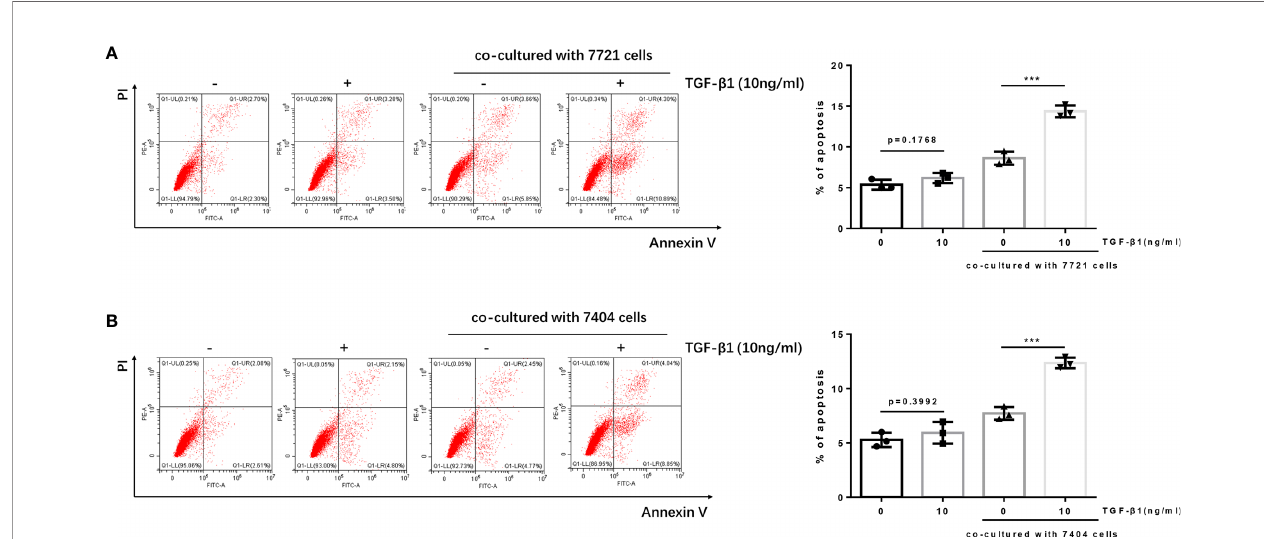
FIGURE 3 | Apoptosis of TGF- b 1-treated H9 cells is increased after co-cultured with HCC cells. (A) TGF- b 1-treated/untreated activated T cells were co-cultured with SMMC-7721 cells or cultured separately for 24 h; subsequently, the apoptosis rate of T cells was detected by fl ow cytometry. (B) TGF- b 1-treated/untreated activated T cells were co-cultured with Bel-7404 cells or cultured separately for 24 h; subsequently, the apoptosis rate of T cells was detected by fl ow cytometry. n = 3, ***P < 0.001 vs. control group.